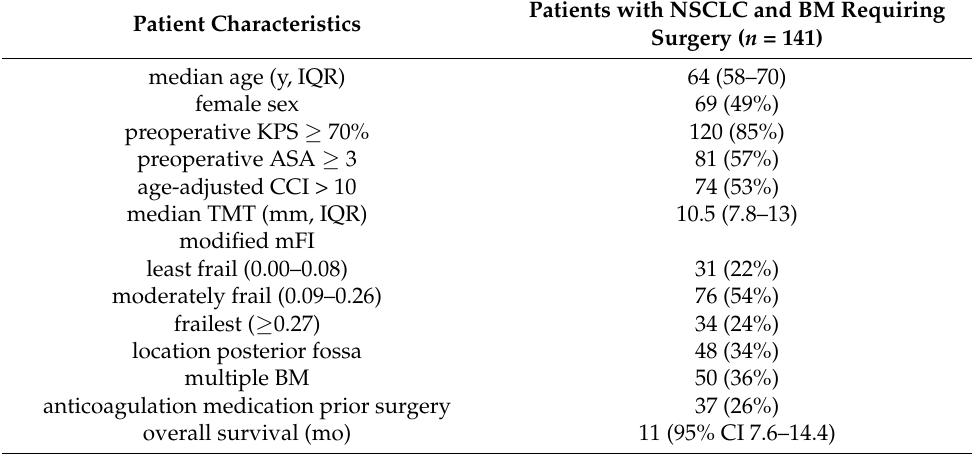
Table 1. Patient